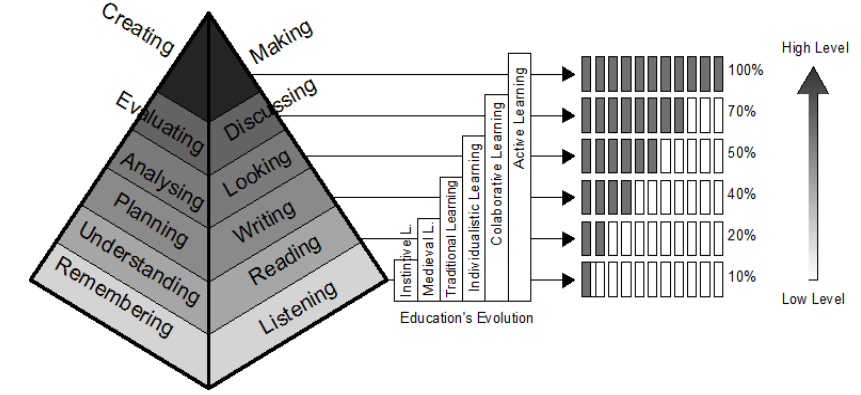
Fig. 2. Relation between the Bloom’s Taxonomy, academic actions, education’s historic evolu- tion, perennial learning percent and thinking levels. Adapted and modified from